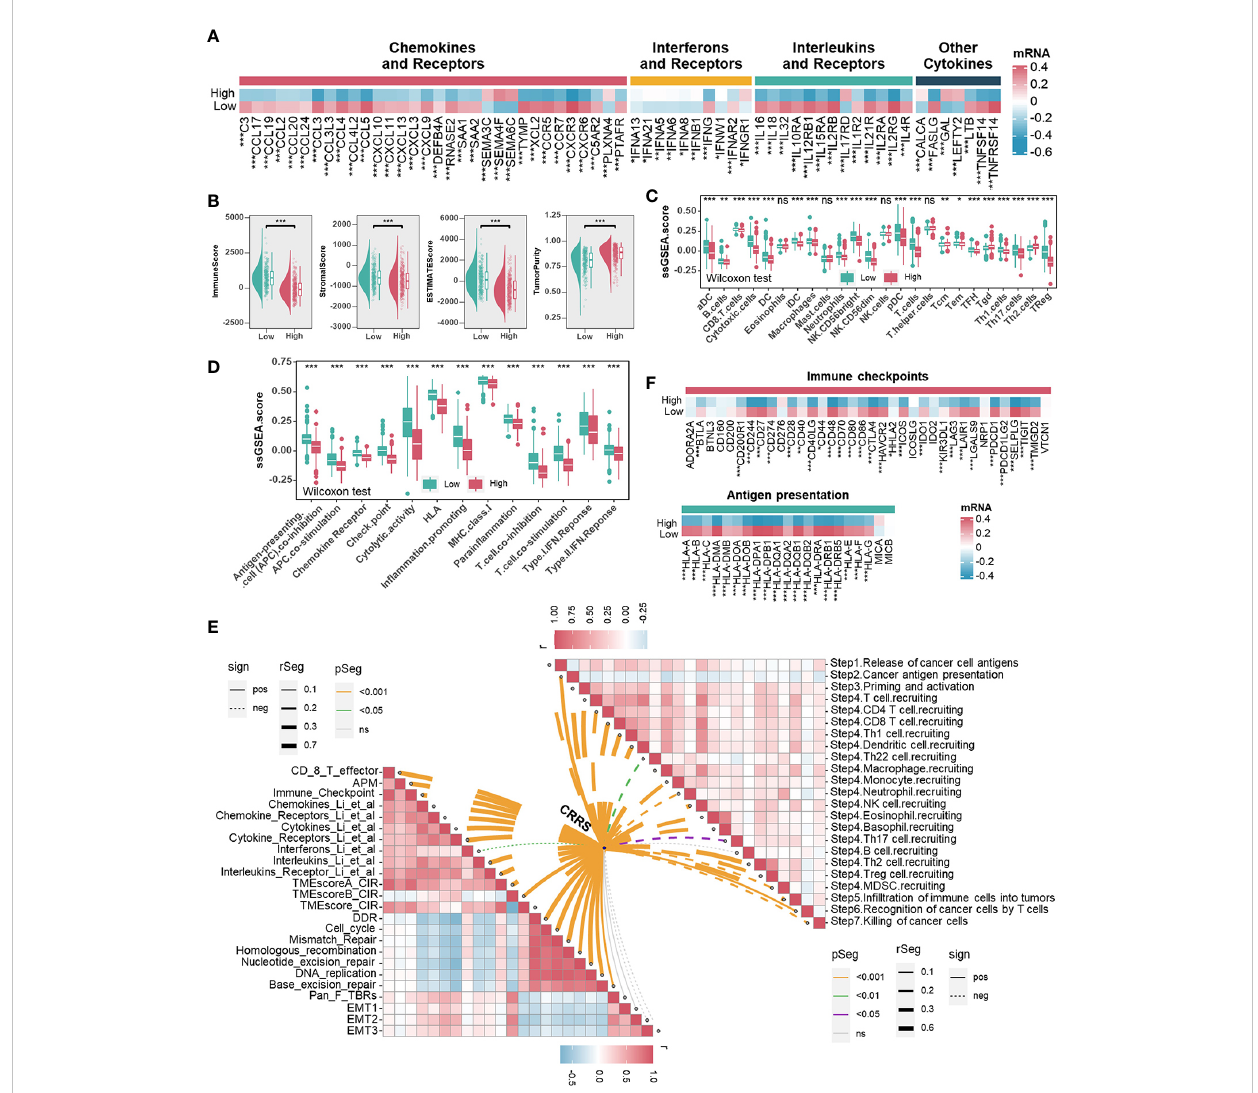
FIGURE 4 Associations between CRRS and the Tumor Microenvironment. (A) . Heatmap illustrating the expression pattern of chemokines, interferons, interleukins, other cytokines, and their receptors in different risk groups. (B) . The correlation between the CRRS and immune score, stromal score, ESTIMATE score, and tumor purity. (C, D) . TME in fi ltrating cell (C) and immune-related functions (D) comparisons between low- and high-CRRS groups. (E) . The lower left panel shows the correlations between the CRRS and immunoregulation-related pathways. The upper right panel shows the correlations between the CRRS and cancer immunity cycles. (F) Immune checkpoints and HLA family gene comparisons between low- and high-CRRS